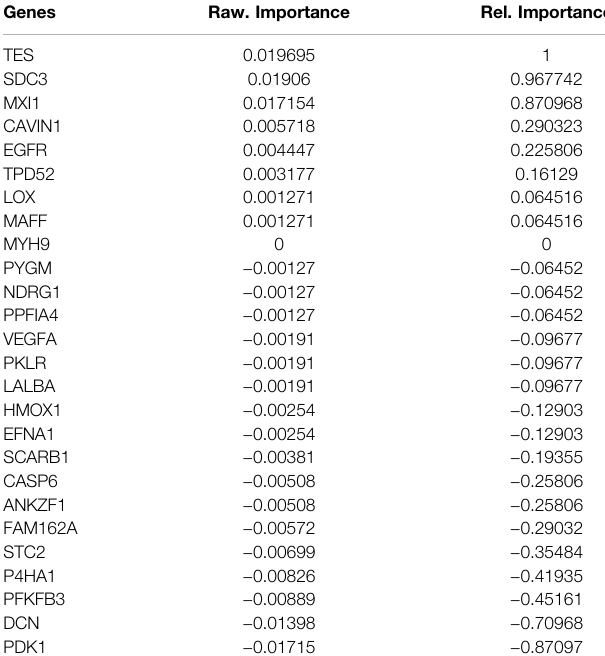
TABLE 2 | The relative importance of prognosis-related hypoxic genes.